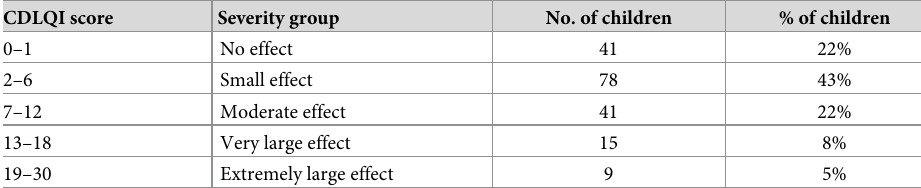
Table 2. CDLQI scores by stratified for